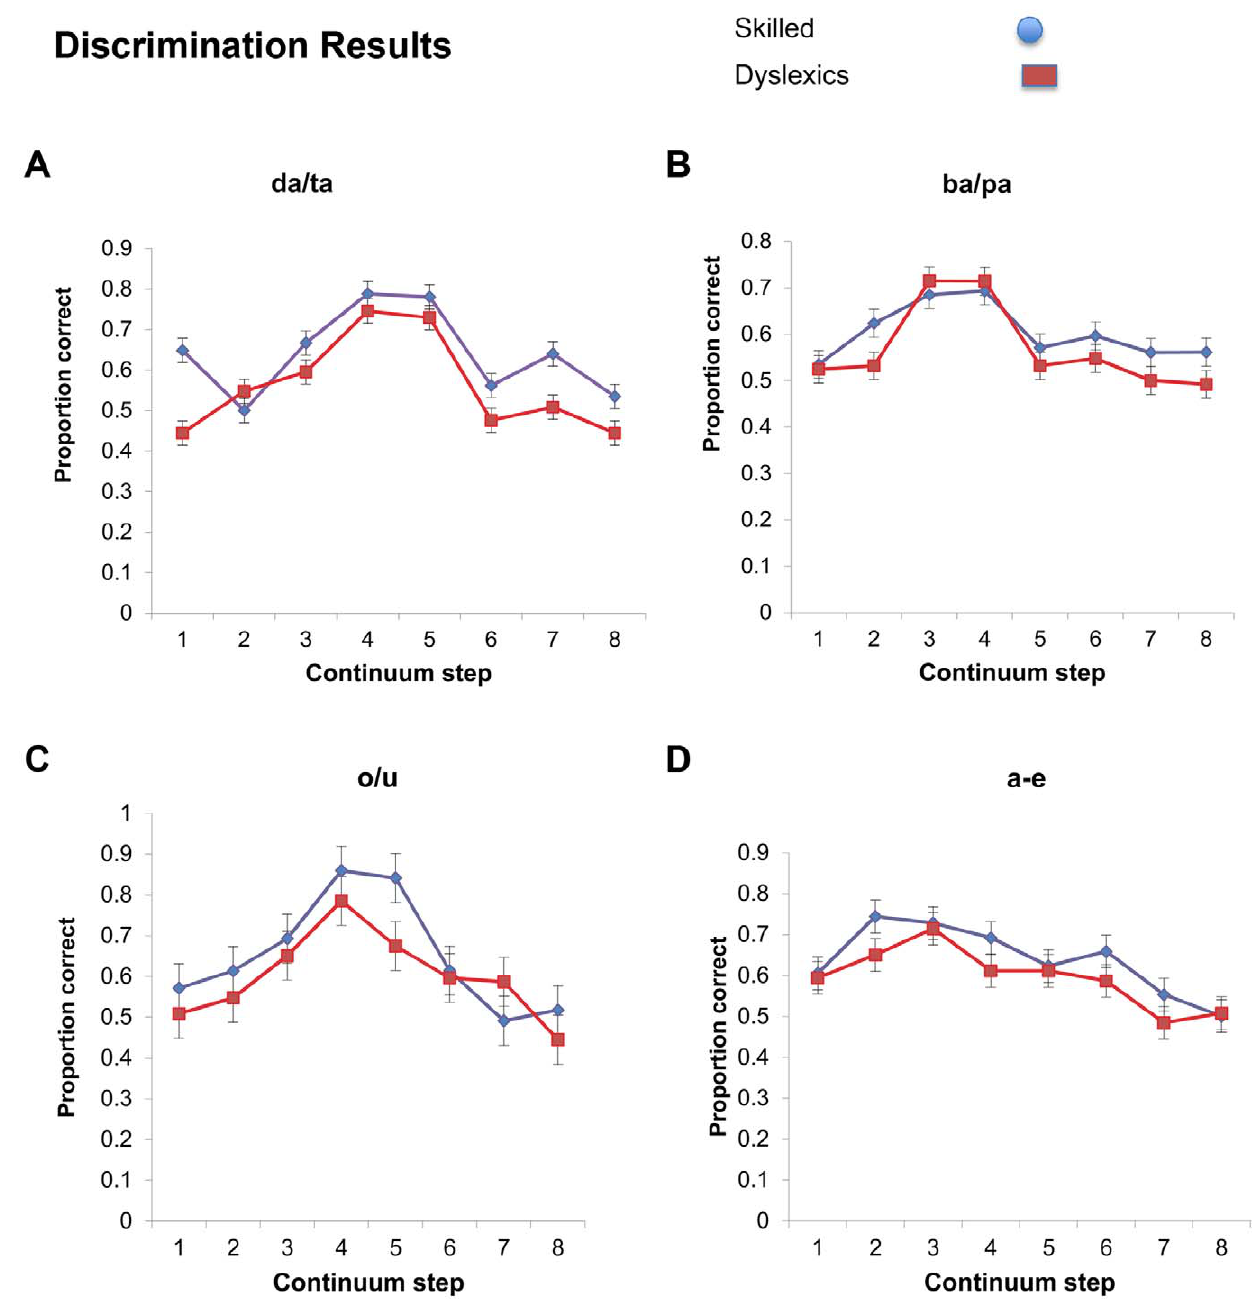
Figure 4. Phonetic discrimination of consonants and vowels by skilled readers and dyslexics along a 10-step continuum. Step continuum denotes the midpoint between the two stimuli (A and B) presented for discrimination. Error bars reflect confidence intervals for the difference between the group means.